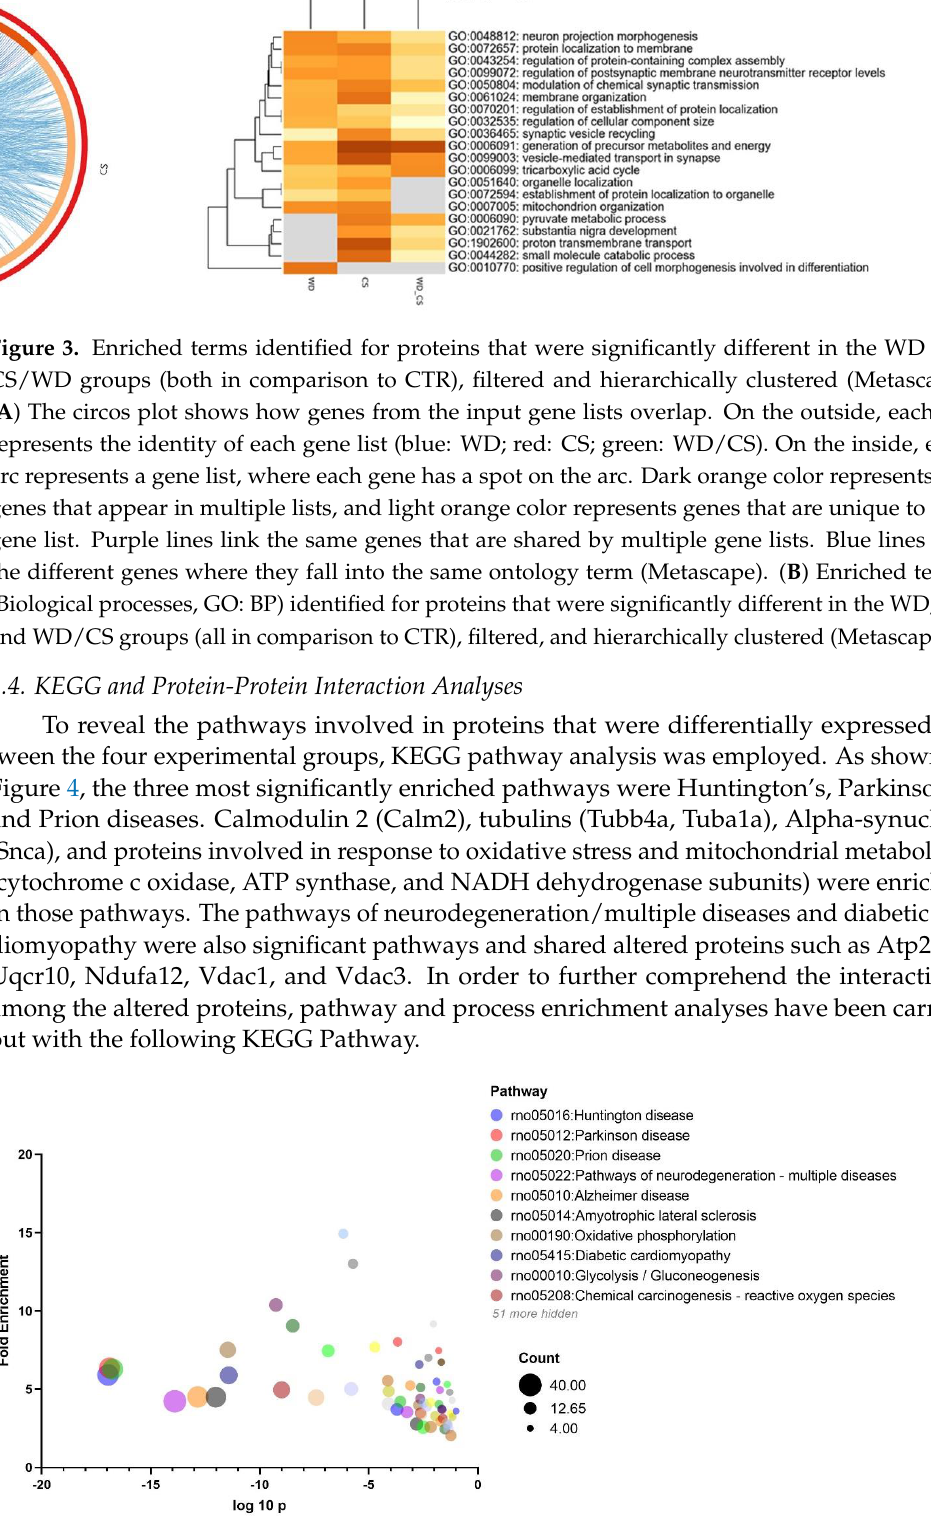
Figure 5. Protein – protein interaction (PPI) networks visualized by Cytoscape software (Institute for Systems Biology, Seattle, Washington, USA). All protein – protein interactions among input genes